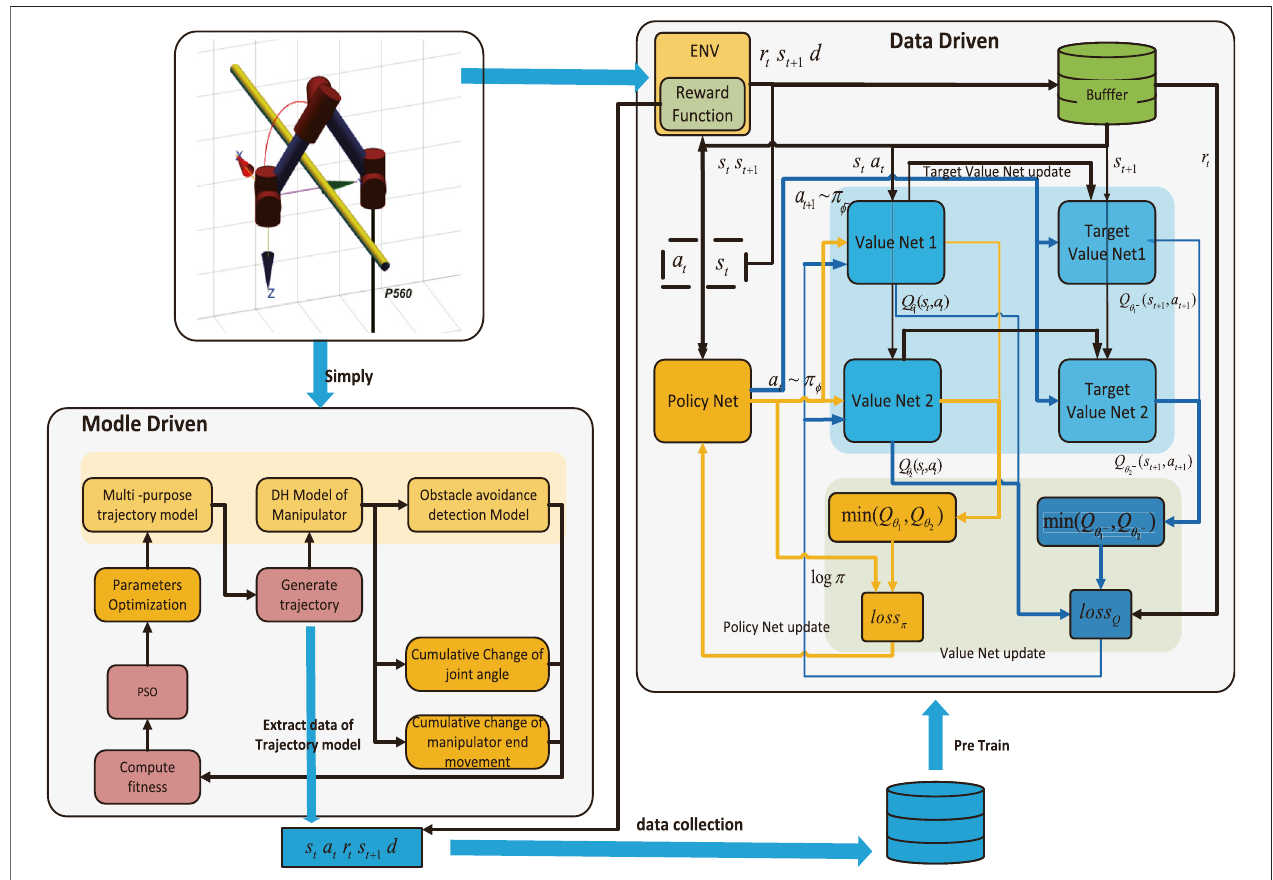
FIGURE 6 | Architecture diagram of P-SAC applied to the live working manipulator.